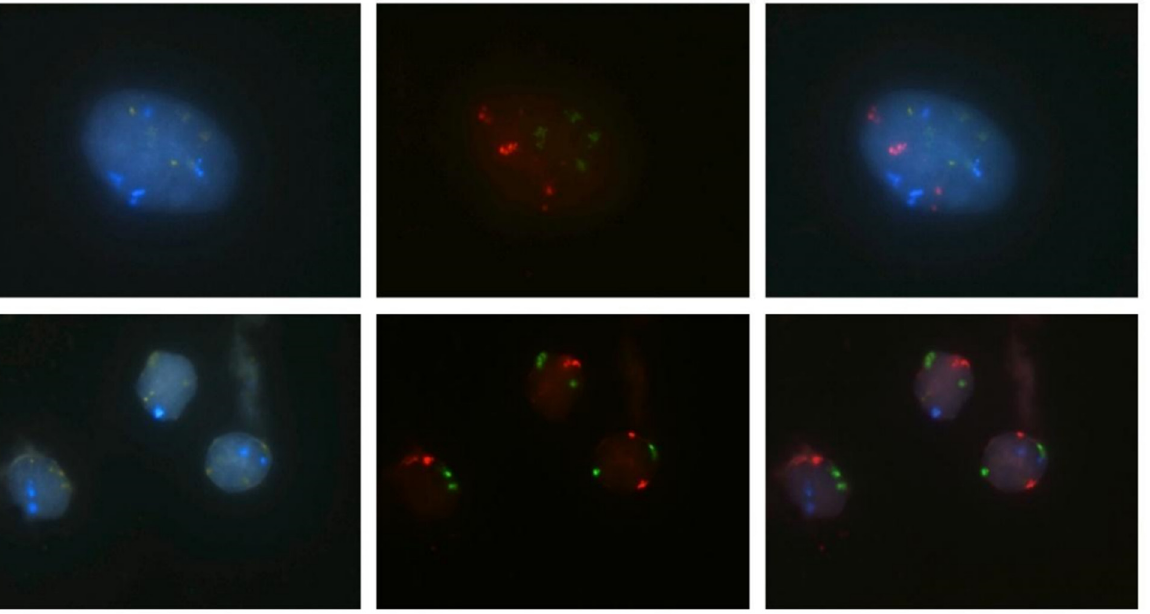
Figure 2. Upper part of Figure 2 (positive FISH): Nucleus of a tumor cell with increased number of red, green, and blue signals indicating polysomy of the chromosomes 3, 7, and 17, respectively. The third image summarizes the colors of all signals; round yellow (gold) signals marking CDKN2 (p16) are clearly visible, so deletion of this gene is not present; Lower part of Figure 2 (negative FISH): Three nuclei of benign cells are visible without increased number of signals for chromosomes 3, 7, and 17, respectively, and without CDKN2(p16) deletion.